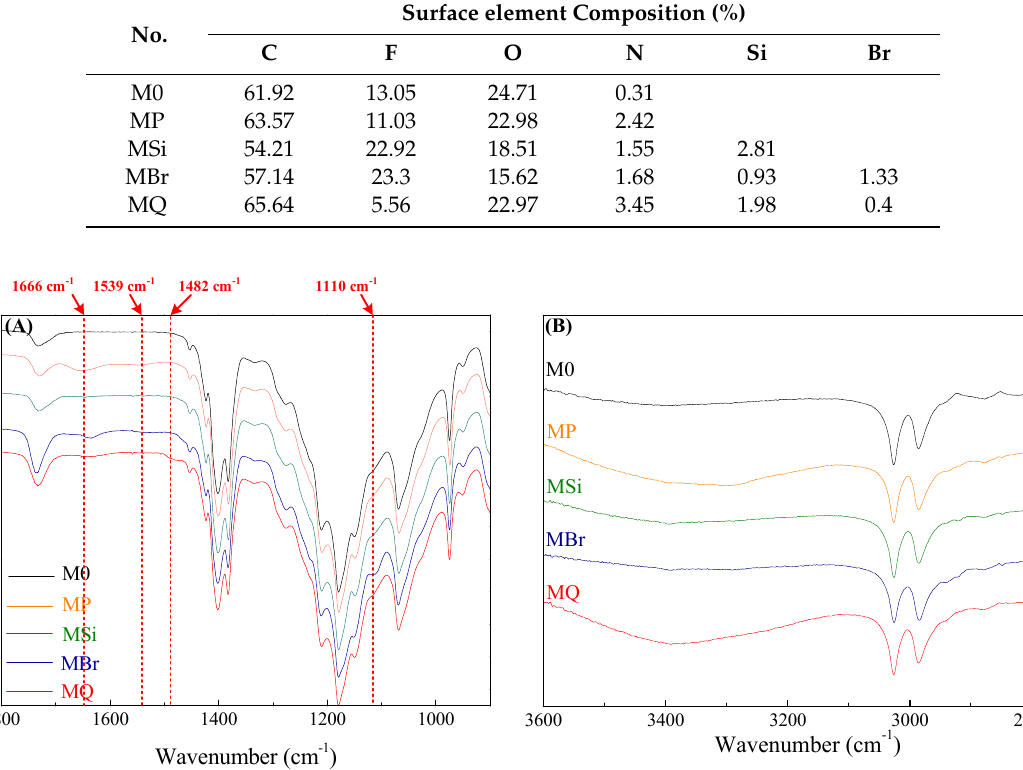
Figure 3. ATR-FTIR spectra from ( A ) 1800 cm − 1 to 900 cm − 1 and ( B ) from 2800 cm − 1 to 3600 cm − 1 of the pristine and modified membranes.